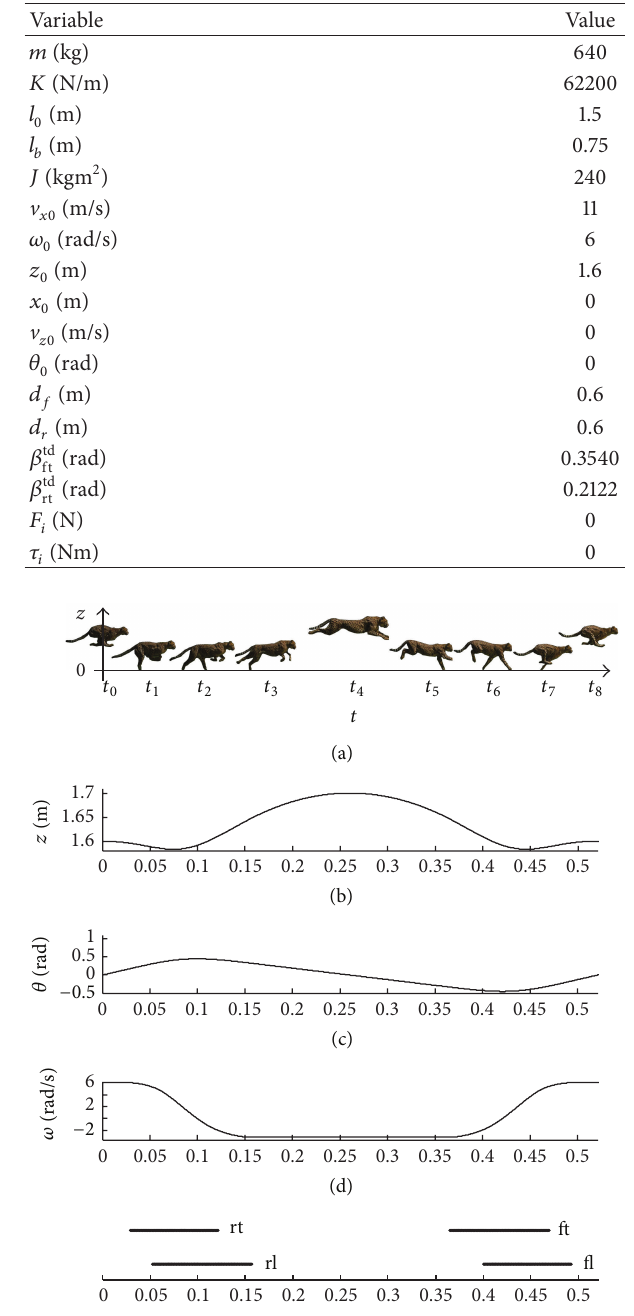
Table 1: System parameters and initial conditions.